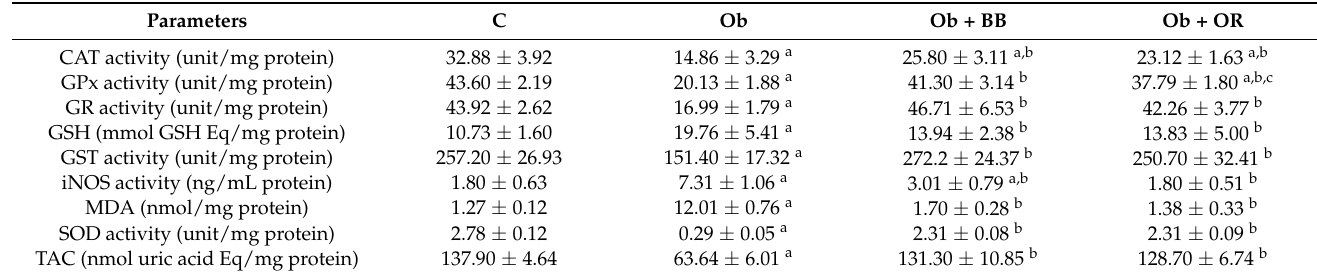
Table 6. Oxidant–antioxidant Parameters in the testis in all groups.